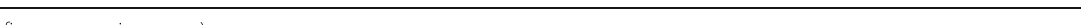
(See figure on previous page.) Fig. 1 Past seismic activities in the study area. a Regional location map (inset) and seismic activity along the Nankai Trough. Orange star represents the epicenter location of the 2016 off-Mie earthquake; results from the Japan Meteorological Agency (JMA), U.S. Geological Survey (USGS), and the Global CMT Project (GCMT) are shown together with mechanism symbols. Epicenters of earthquakes larger than M6 before and after 1976 are represented by diamonds and circles, respectively, from the JMA unified earthquake catalogue. Blue and red contours represent the slip distributions of the 1944 Tonankai and 1946 Nankai earthquakes, respectively (Ichinose et al. 2003; Murotani et al. 2015). Gray triangles represent locations of DONET stations. The ellipsoid labeled with “ A ” designates the region of interplate seismic activity reported by Akuhara and Mochizuki (2014). Orange arrows represent the subduction direction of the Philippine Sea plate. Plate name abbreviations are as follows: AM, Amur; OK, Okhotsk; PA, Pacific; PS, Philippine Sea. b Occurrence date of earthquakes plotted against their source longitude. Symbols are the same as in